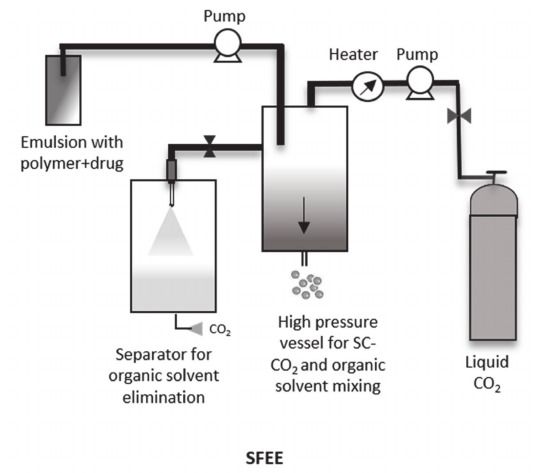
Figure 6. Schematic representation of SFEE process.